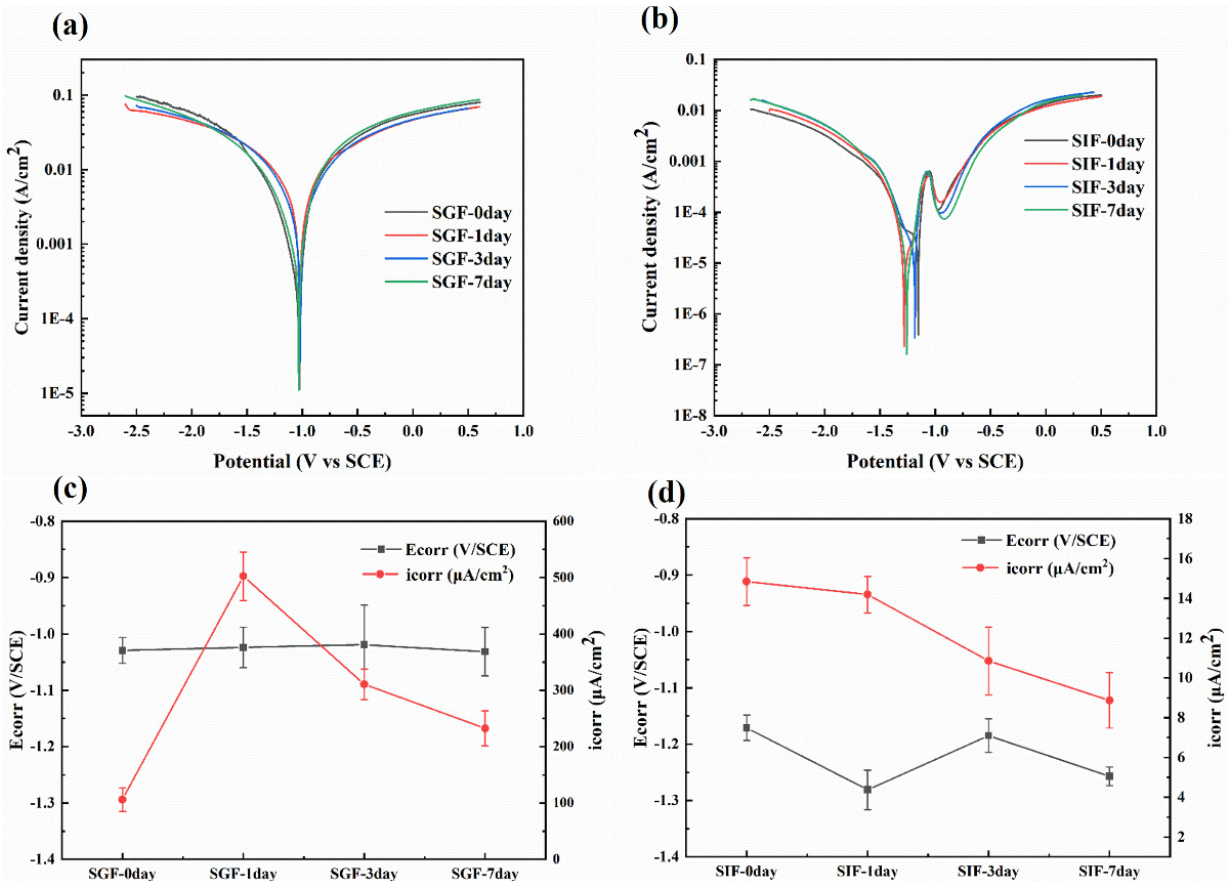
Figure 8. PDP curves of Zn–0.4Li after immersion in SGF ( a ) and SIF ( b ) for different times. Electro- chemical parameters of the samples after immersion in SGF ( c ) and SIF ( d ).